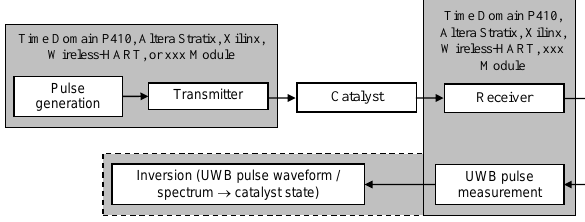
Figure 2. Functional diagram of the proposed measurement system.